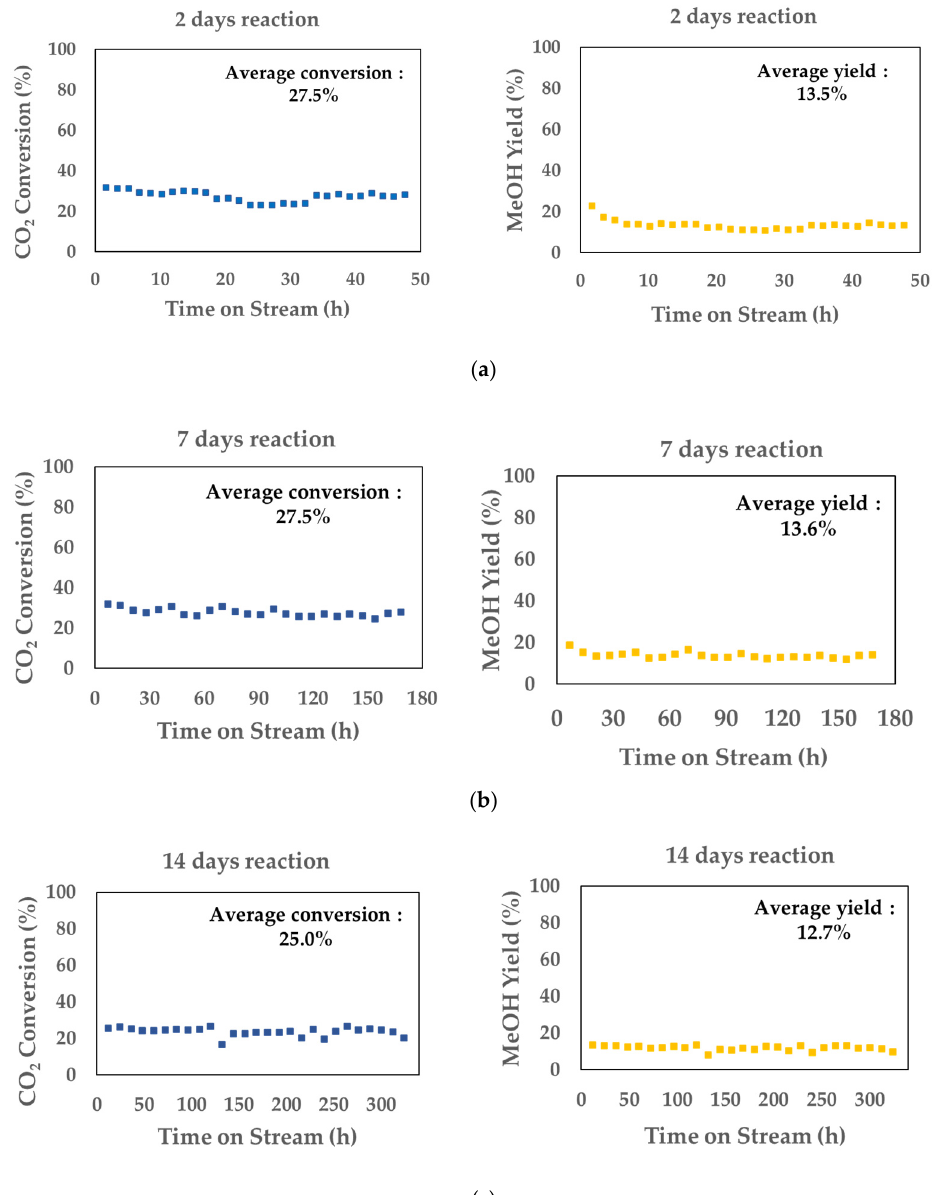
Figure 1. Time-on-stream plots for ( a ) 2 days ( b ) 7 days and ( c ) 14 days reaction.